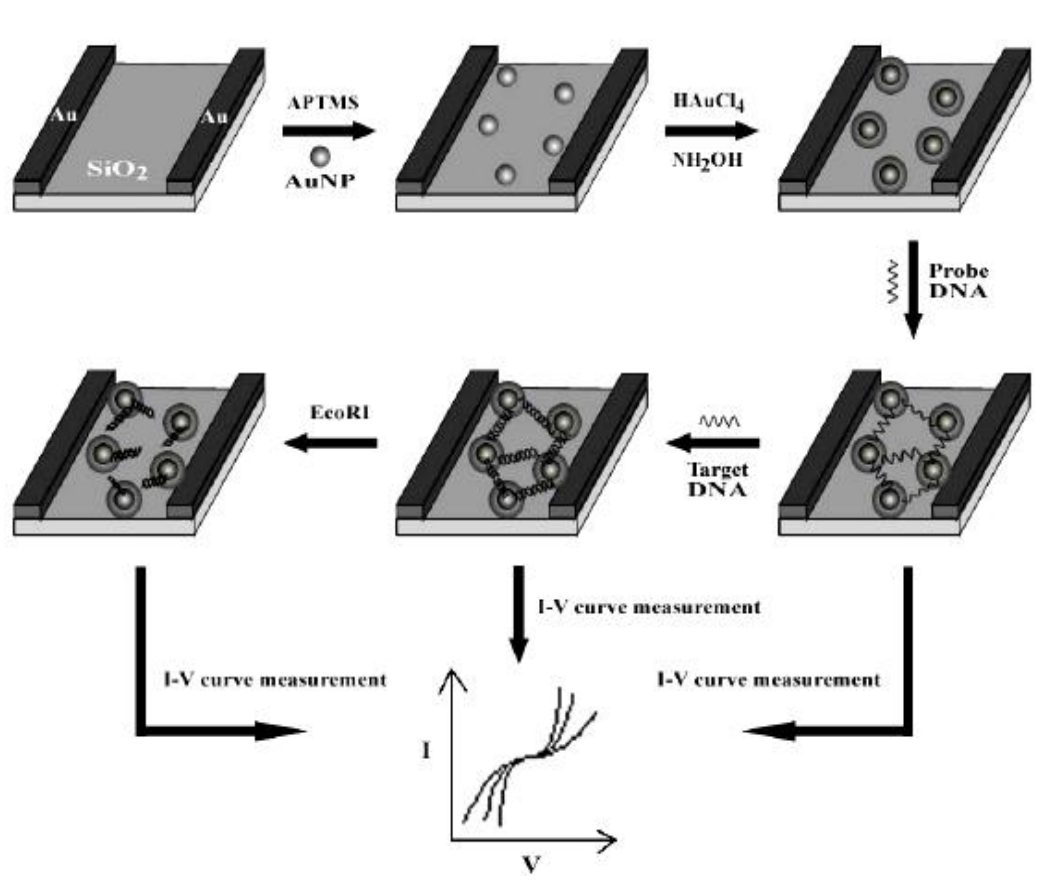
Figure 4. Schematic illustration of in situ seed-assisted growth of nanogapped AuNPs for the electrical detection of DNA hybridization. Reprinted with permission from [86]. Copyright (2008) Elsevier